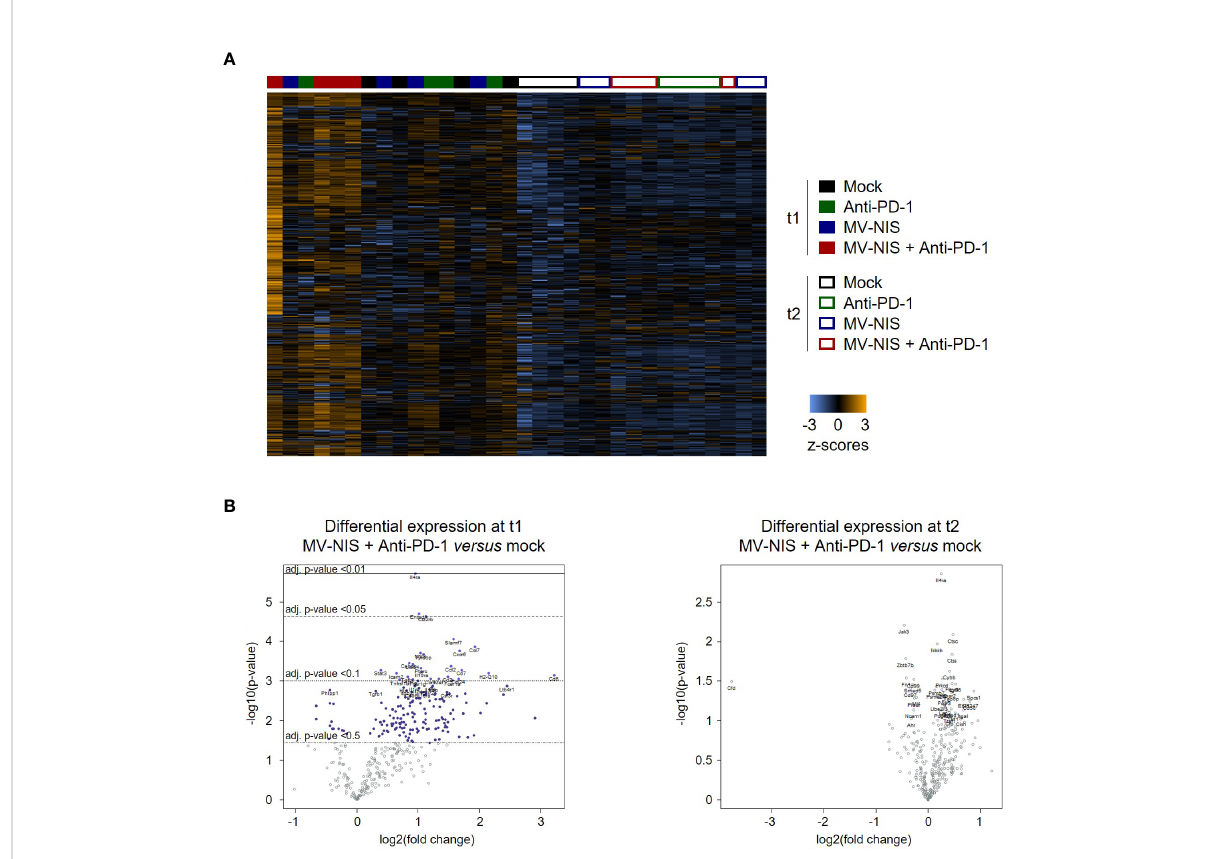
FIGURE 6 Gene expression pro fi ling. (A) Dendrogram and heatmap depicting gene expression pro fi les of n = 3-4 samples for each timepoint and treatment. Analysis was performed with the Advanced Analysis package of nSolver 4.0 using hierarchical clustering. (B) Volcano plots showing differentially expressed genes between mock and MV-NIS plus anti-PD-1 treatment at t1 and t2. Analyses were performed with the Advanced Analysis package from nSolver